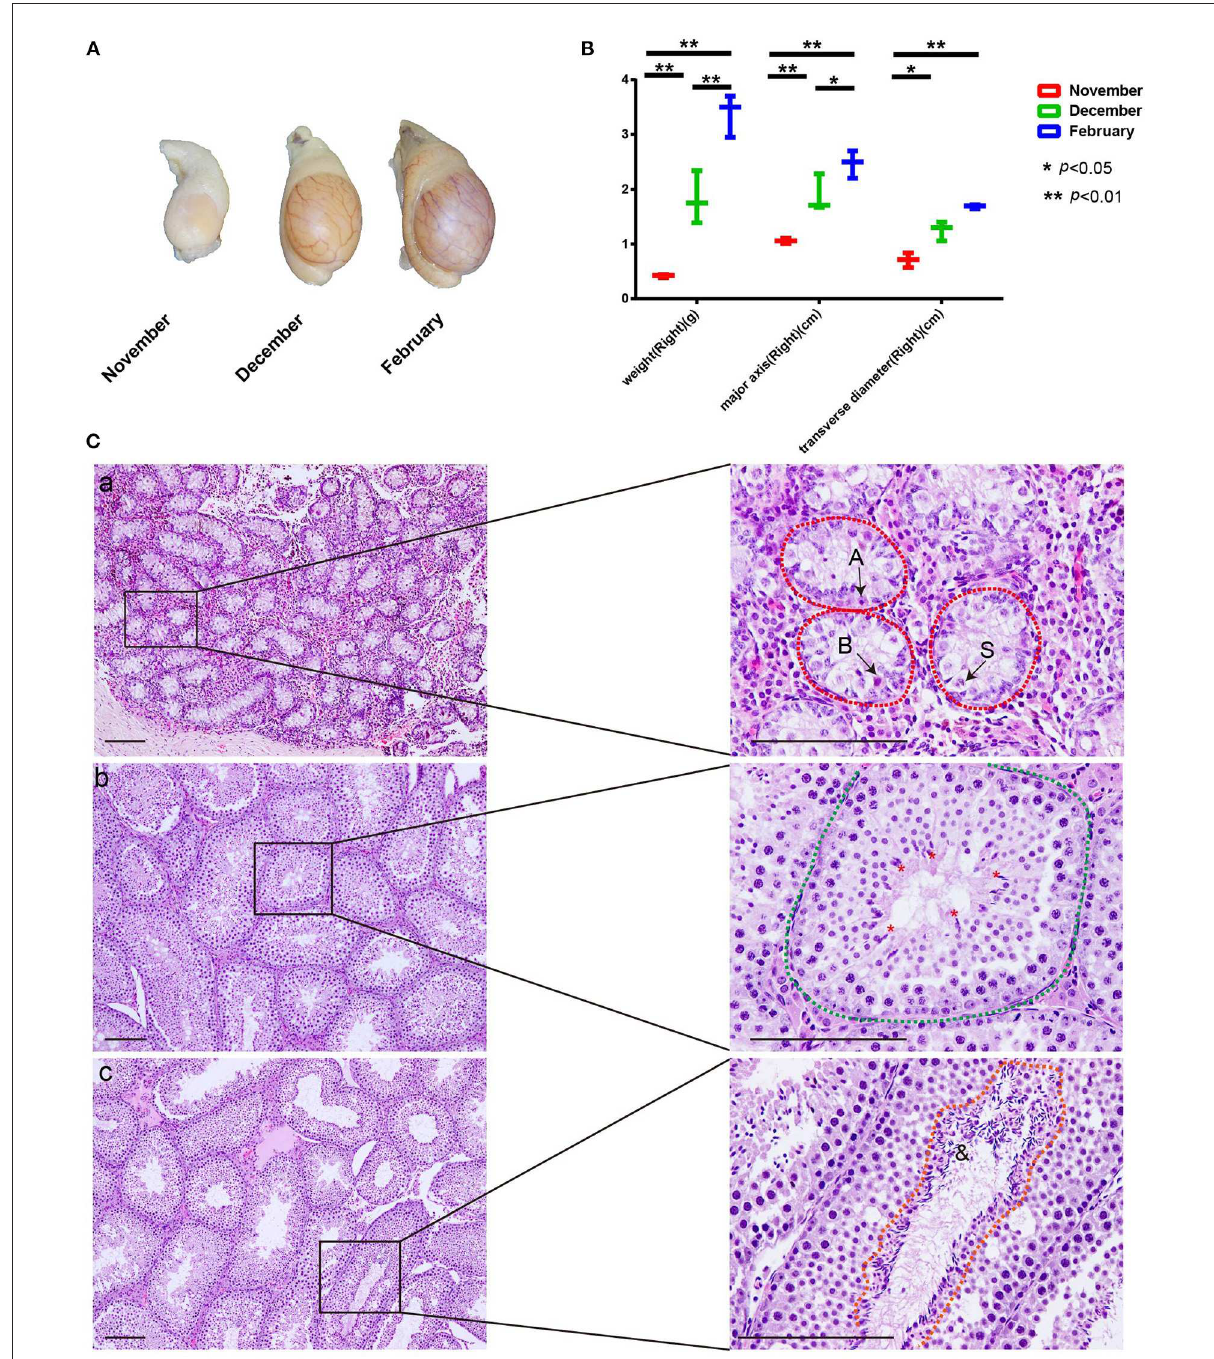
FIGURE1 Changes in testis weight and histological morphology of seminiferous tubule during seasonal spermatogenesis in mink. (A) The volume of mink testes increased significantly during seasonal spermatogenesis. (B) Mink testis weight enhanced significantly with volume during seasonal. spermatogenesis. (C) In November, the seminiferous tubules were composed of large gonocyte-like germ cells (A: Type A spermatogonia, B: Type B spermatogonia, S: Sertoli cell). Furthermore, the Sertoli cell nuclei migrated to the center of the seminiferous tubules (C-a) . In December, spermatocyte meiosis was completed. Step 7 spermatids were present in the seminiferous epithelium (*: Spermatids) (C-b) . In February, the seminiferous tubules of the mink exhibited a normal spermatogenic epithelium during the breeding season (&: Sperm) (C-c)